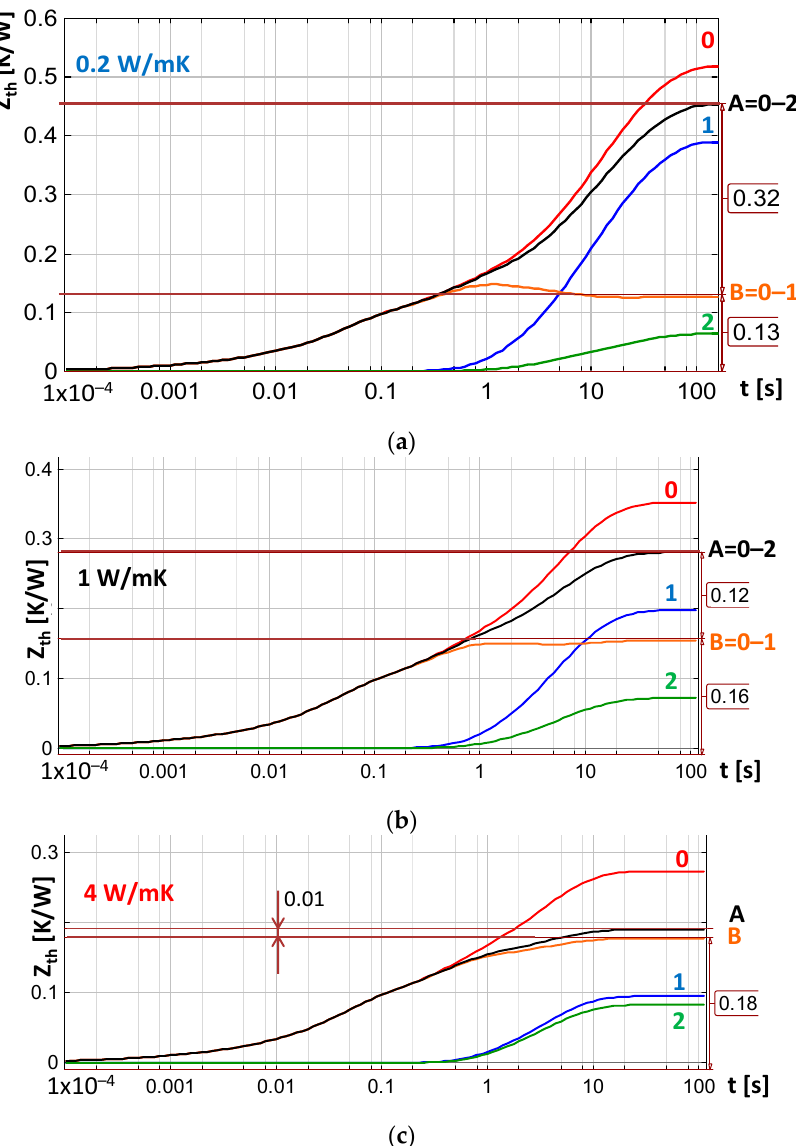
Figure 6. Zth curves, at junction and sensor locations, at TIM thermal conductivity: ( a ) 0.2 W/mK, ( b ) 1 W/mK, ( c ) 4 W/mK. Ch0: junction, Ch1: case center, Ch2: cold plate top position.